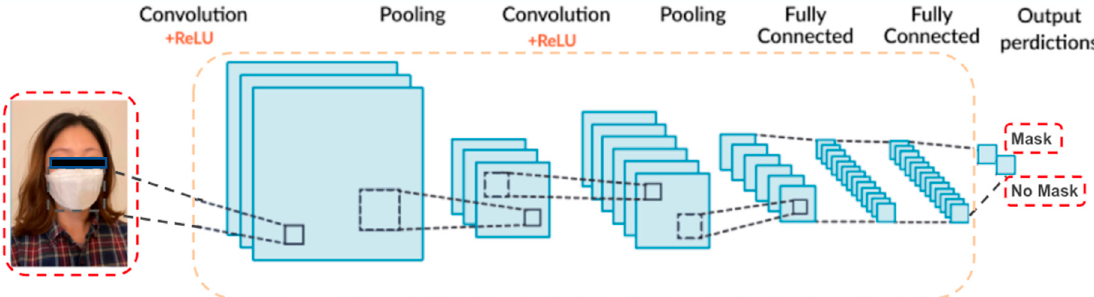
Figure 4. CNN Architecture for Mask Detection.